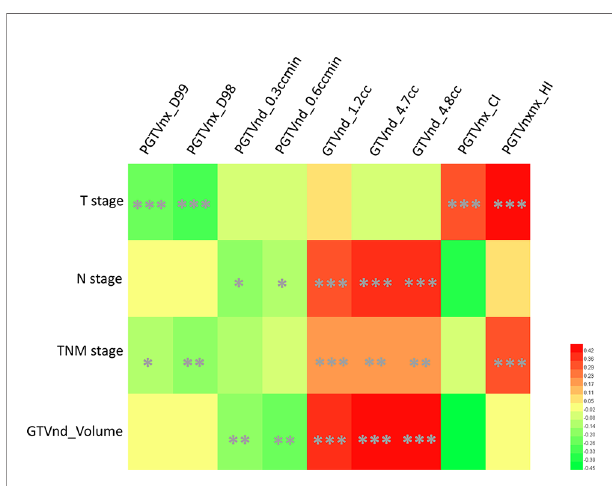
FIGURE 2 | A heat map of associations between selected dosimetric parameters and tumor-related data. *P ≤ 0.05, **P ≤ 0.01, ***P ≤